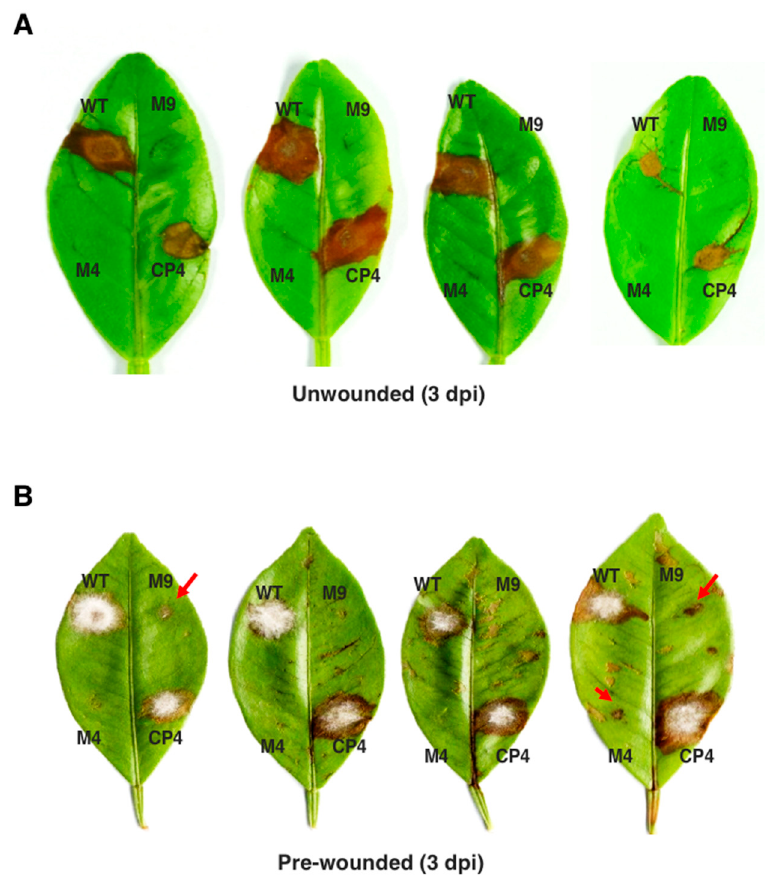
Figure 6. Pex6 is required for A. alternata pathogenicity and lesion formation. ( A ) Fungal pathogenicity was assayed on detached calamondin leaves; ( B ) Fungal pathogenicity was assayed on citrus leaves that were wounded before inoculation. Each spot was inoculated with 5 µl of conidial suspensions (10 5 conidia per milliliter) prepared from the wild-type (WT) two pex6 mutants ( Δ pex6 -M4 and M9) or the complementation strain (CP4). The leaves were maintained in a moisture chamber for lesion development. M4 and M9 induced much smaller lesions (indicated by red arrows). Each strain was tested on at least five different leaves and experiments were repeated at least three times.